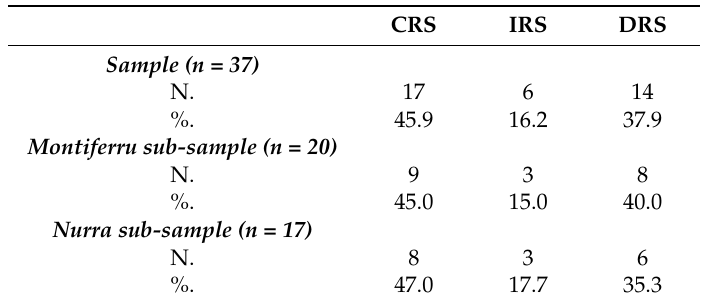
Table 5. Estimated returns to scale by DEA.